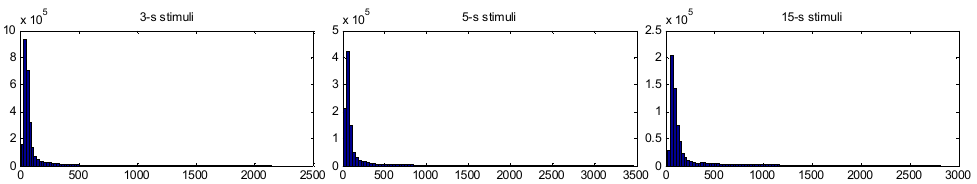
Figure 10. Histograms approximating the shape of sample distributions of the distance evaluated for spatial EEG vectors corresponding to the three color stimuli.